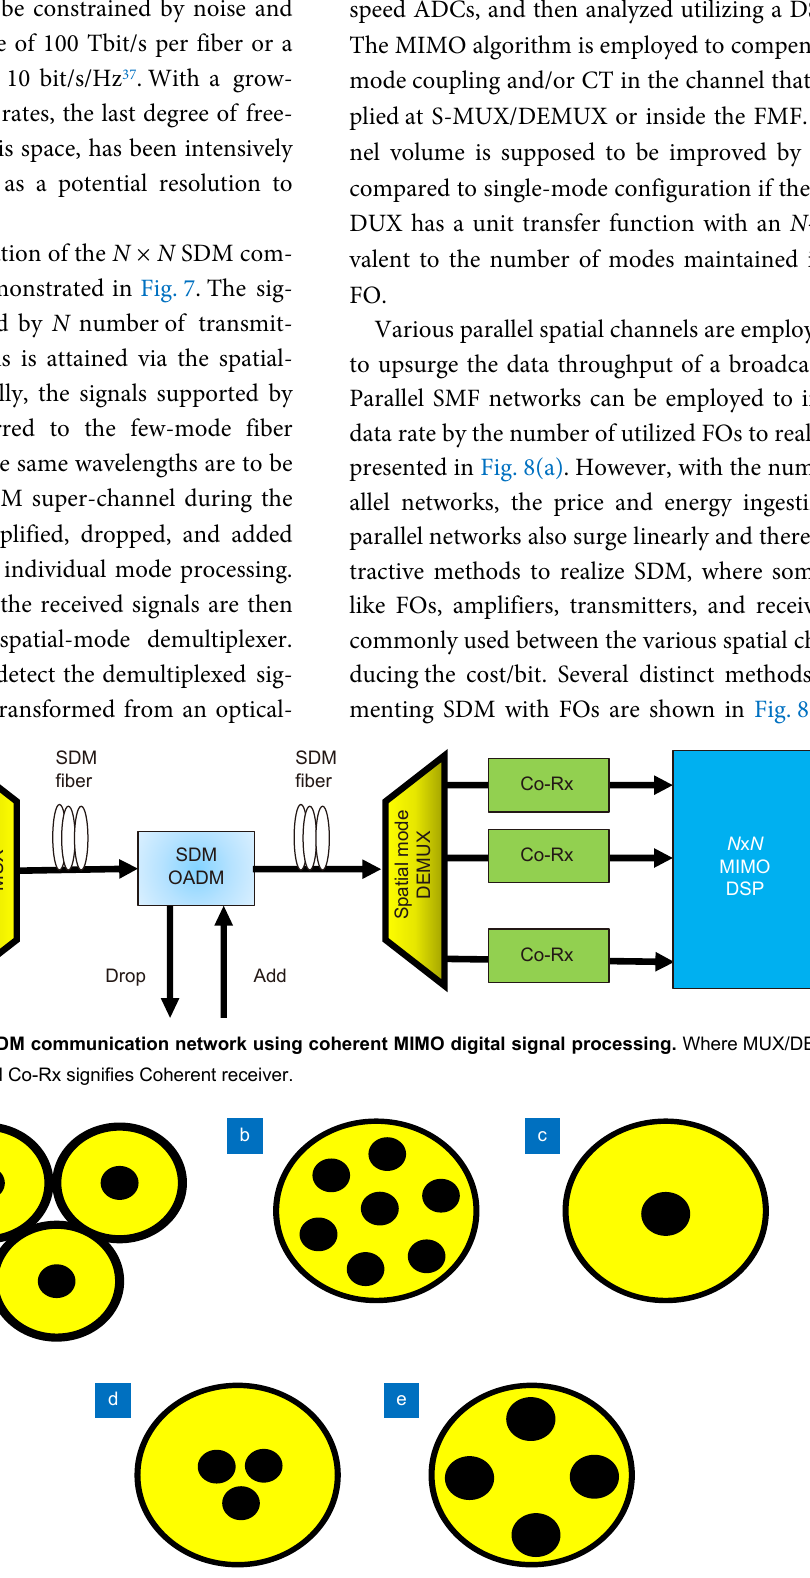
Fig. 8 | Different dissimilarities of FOs for SDM. ( a ) FO bundle, possibly with compact cladding diameter. ( b ) Multicore FO with uncoupled cores. ( c ) Few-mode FO. ( d ) Coupled-core multicore FO. ( e ) Multi-mode-multicore FO, in which each core supports more than one